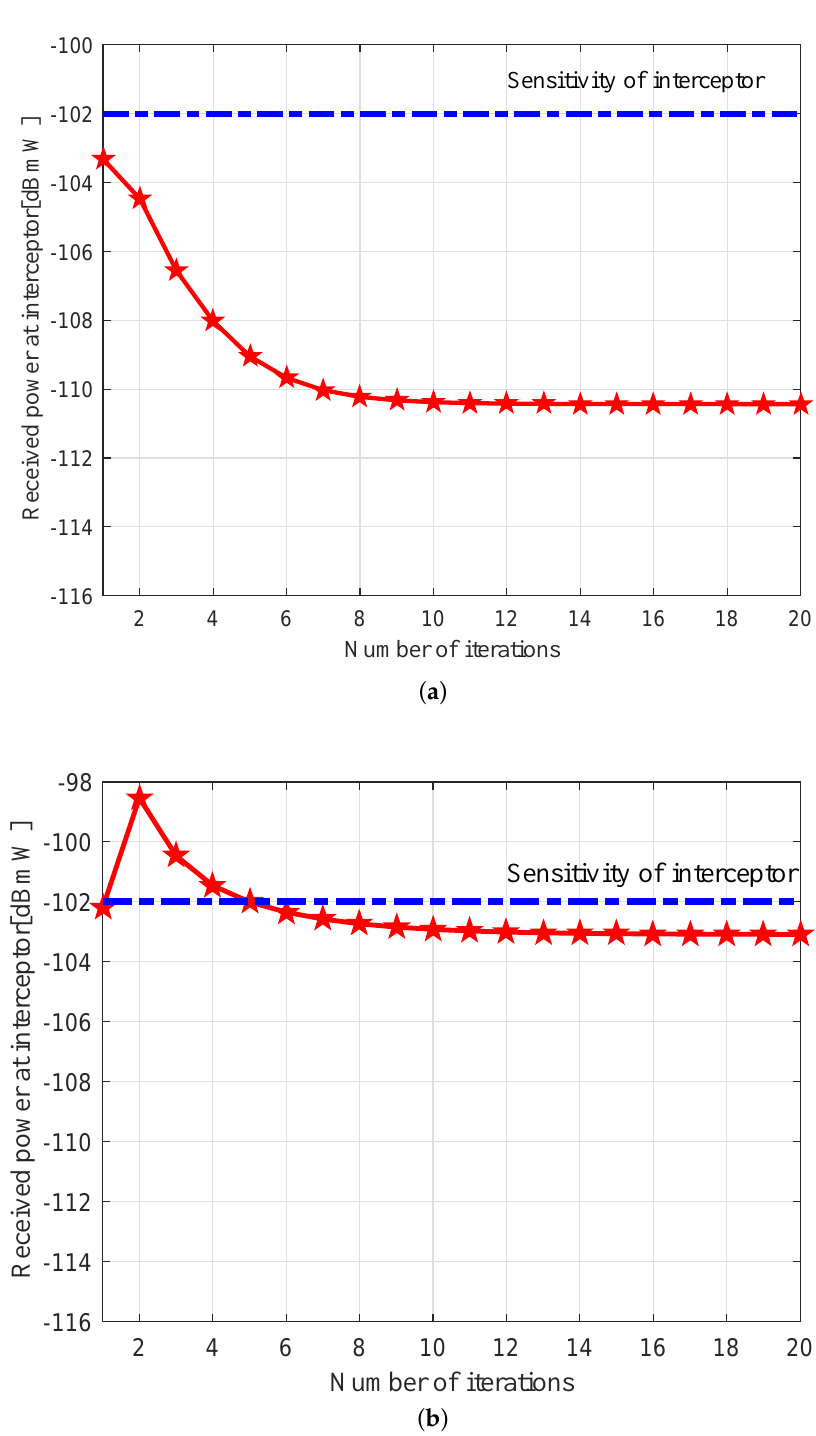
Figure 10. Convergence behavior for the received power at intercept receiver in the first case: ( a ) Target position is [ 0,0 ] km; ( b ) Target position is [ − 30, − 40 ]